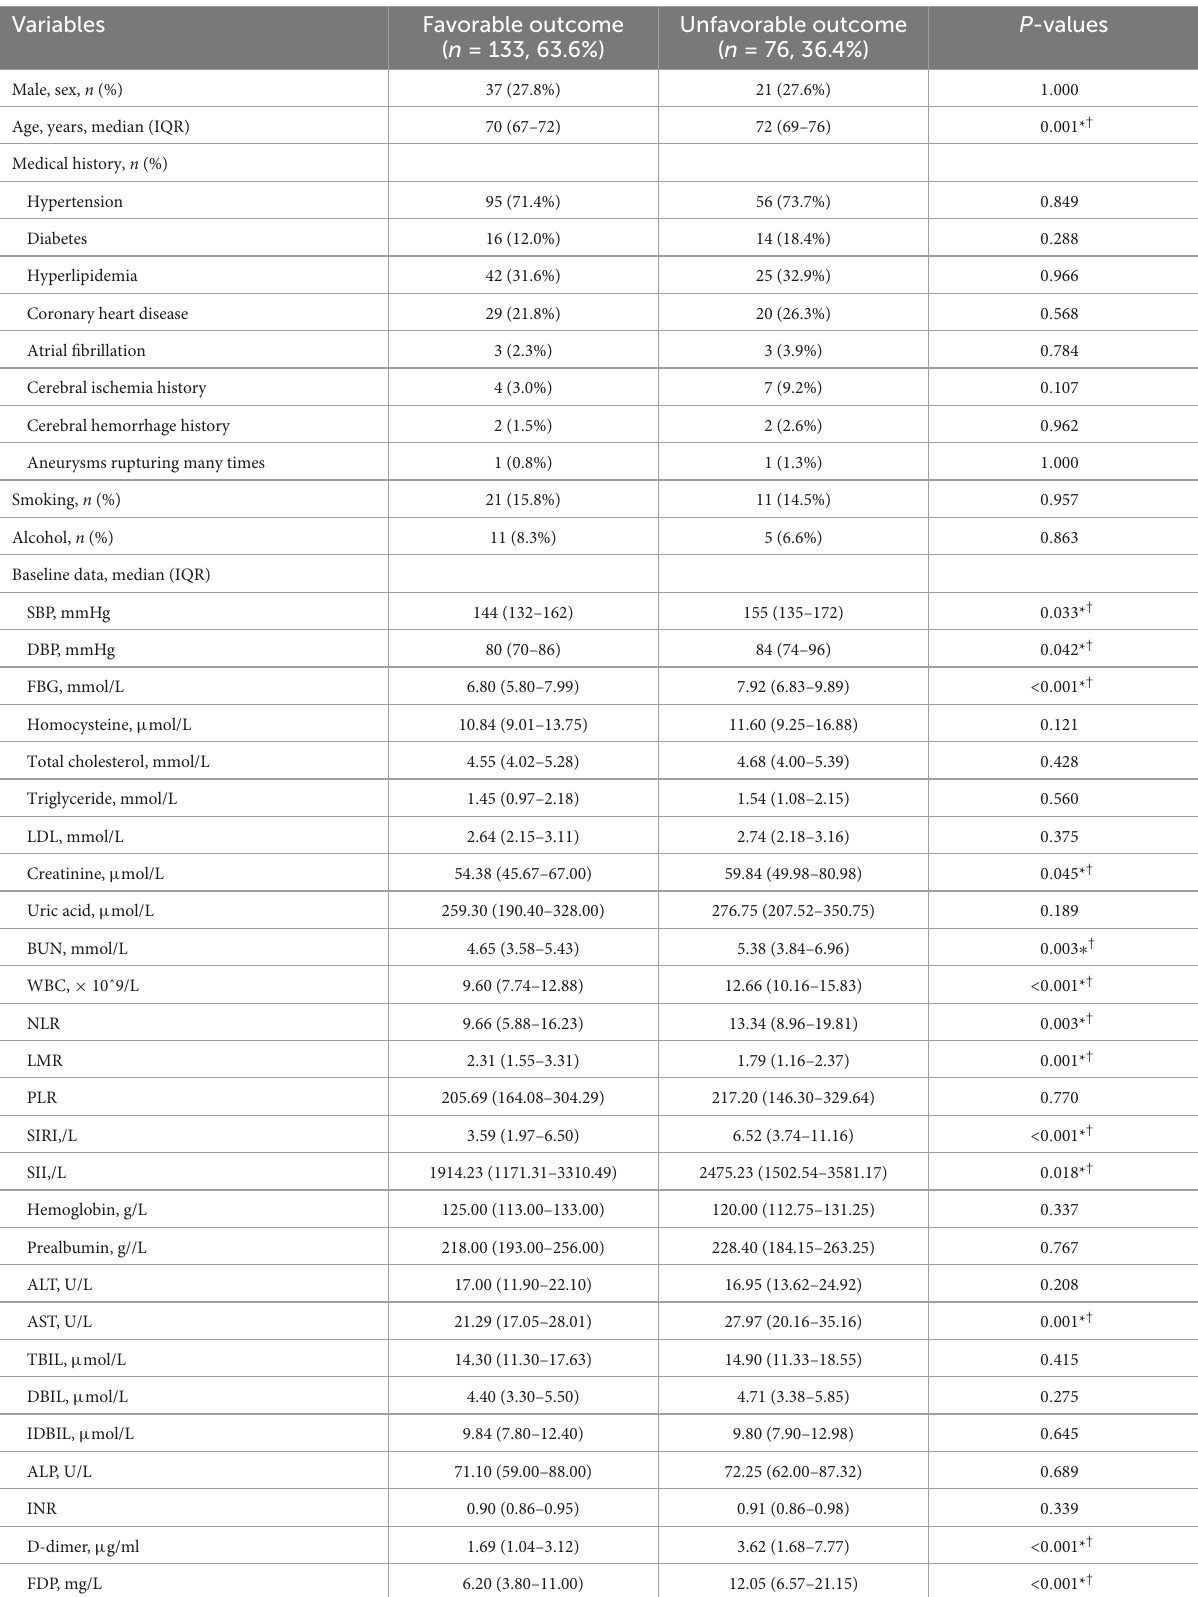
TABLE 1 Clinical, demographic, and laboratory data of patients with aSAH treated by endovascular coiling. Variables Favorable outcome